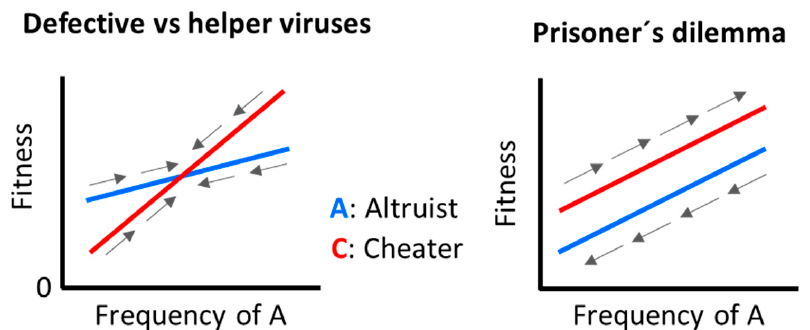
Figure 1. Two examples of altruistic-cheater virus interactions. Both defective-helper systems and Prisoner´s dilemma exhibit frequency-dependent selection, but they di ff er in the arrangement of fitness values, leading to di ff erent population dynamics. Defective viruses cannot reach fixation because they ultimately depend on helper variants. In contrast, in Prisoner´s dilemma, the cheater fully outcompetes the altruistic variant. Arrows indicate the direction of selection.